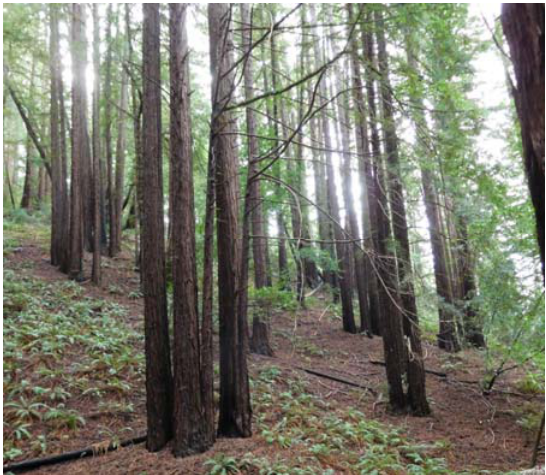
Figure 1. Young even ‐ aged redwood forest demonstrating strongly aggregated spatial pattern due to origin of these trees from stump sprout clumps. Photograph taken in Alameda County, CA, USA.